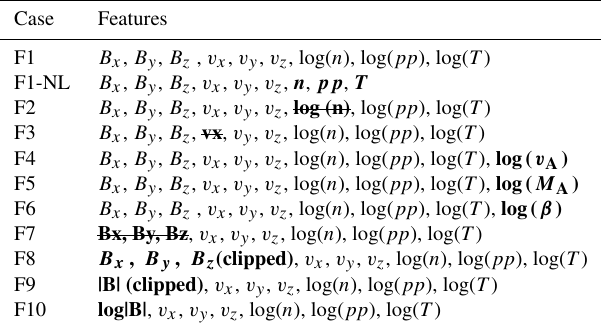
Table 1. Combination of features (cases) used for the different clas- sification experiments. We mark differences with respect to F1, our reference feature set, in